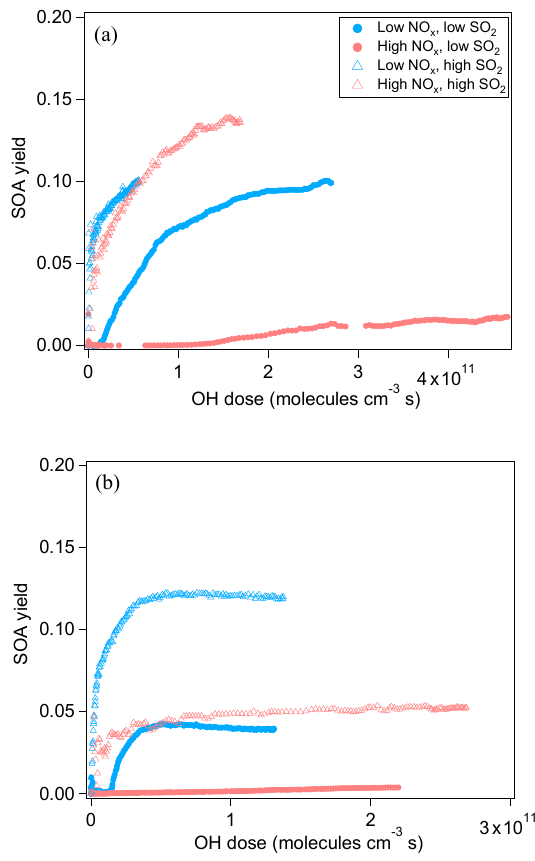
Figure 3. SOA yield of the photooxidation of α -pinene (a) and limonene (b) in different NO x and SO 2